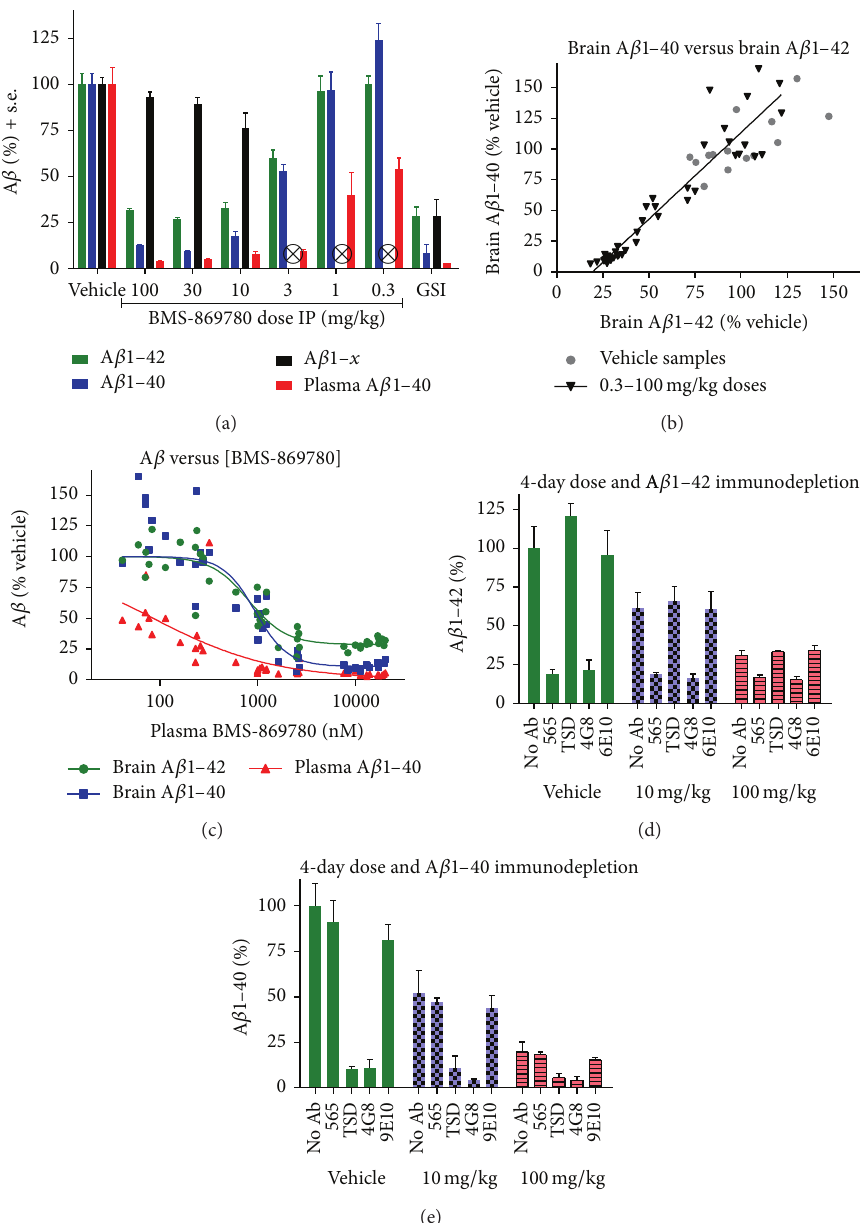
Figure 7: BMS-869780 dose response and evaluation of residual A 𝛽 levels in rat brain. (a) Groups of rats received intraperitoneal (IP) injections of vehicle orBMS-869780 at dosesof 100,30, 10,3, 1,and 0.3 mg/kg. Additional ratswere dosed with GSI BMS-698861at 30 mg/kg as a positive control for A 𝛽 -lowering. Group sizes were seven rats for each dose of BMS-869780 and 14 rats for vehicle and GSI dose groups. Brain and plasma were harvested 5 hours after dosing. Brain A 𝛽 1-42 (green), brain A 𝛽 1-40 (blue), brain A 𝛽 1- x (black), and plasma A 𝛽 1-40 (red) were determined. Values are expressed as % relative to vehicle group mean. Whiskers represent standard error. ⊗ A 𝛽 1- x was not determined in the groups dosed at 3, 1, and 0.3 mg/kg. (b) Brain A 𝛽 1-40 was plotted against brain A 𝛽 1-42 for each rat dosed with BMS-869780 (black 󳶃 ) and for each rat dosed with vehicle (grey e ). Values are expressed as % relative to vehicle group mean. Whiskers represent standard error. (c) Brain A 𝛽 1-42 ( e ), brain A 𝛽 1-40 ( ◼ ), and plasma A 𝛽 1-40 ( 󳵳 ) were plotted against plasma concentration of BMS-869780 and the data were evaluated by fit to a four-parameter dose response curve. The top of the dose response curve was defined by vehicle group mean (100%), and the apparent IC 50 values in terms of the plasma BMS-869780 concentration obtained for brain A 𝛽 1-42, brain A 𝛽 1-40, and plasma A 𝛽 1-40 were 807 nM, 943 nM, and 84 nM, respectively. The respective 95% confidence intervals were 618–1053 nM, 704–1264 nM, and 44–158nM. (d) Rats were dosed once daily with BMS-869780 for 4 days at 10 and 100mg/kg or vehicle, plasma, and brain samples were taken 5 hours after the last dose, and immunodepletion of brain extracts was carried out prior to A 𝛽 1-42 ELISA assays. Specific monoclonals used were 565 (A 𝛽 1-42 selective), TSD (A 𝛽 1-40 selective), 4G8 (binds both A 𝛽 1-42 and A 𝛽 1-40), and 6E10 (does not bind rat A 𝛽 ). After immunodepletion, A 𝛽 1-42 was assayed by ELISA. (e) Same as described in (d), except that A 𝛽 1-40 ELISA was carried out following the